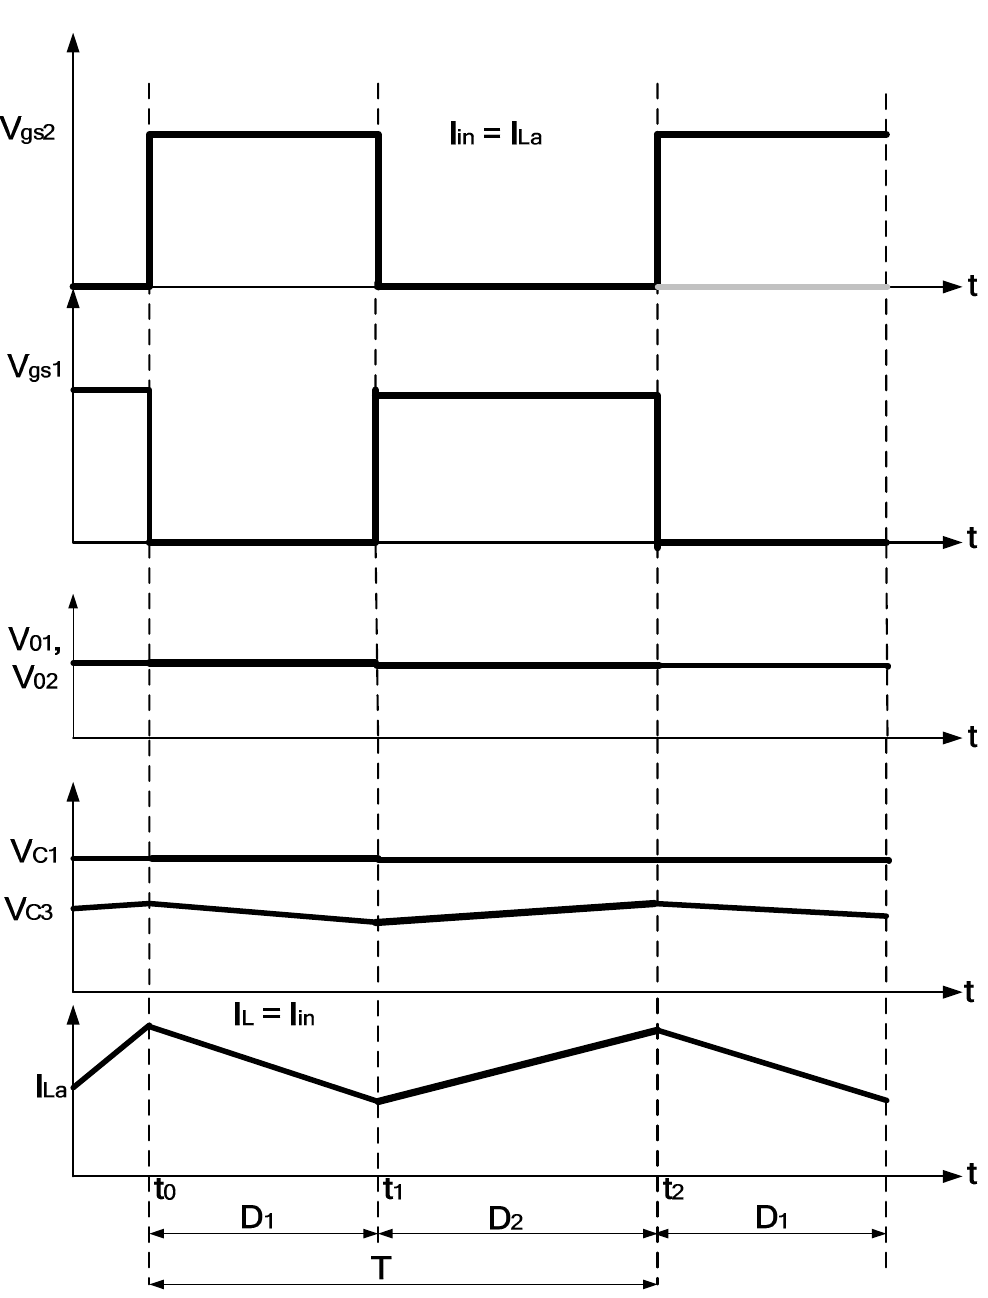
Figure 6. The proposed converter’s theoretical operational